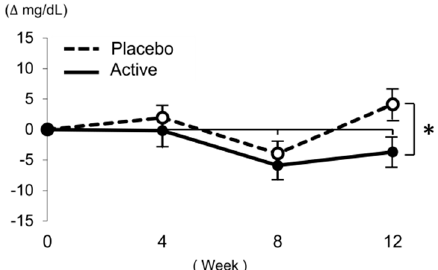
Table 5. Lipid profiles and adiponectin levels for the placebo and active food test groups.